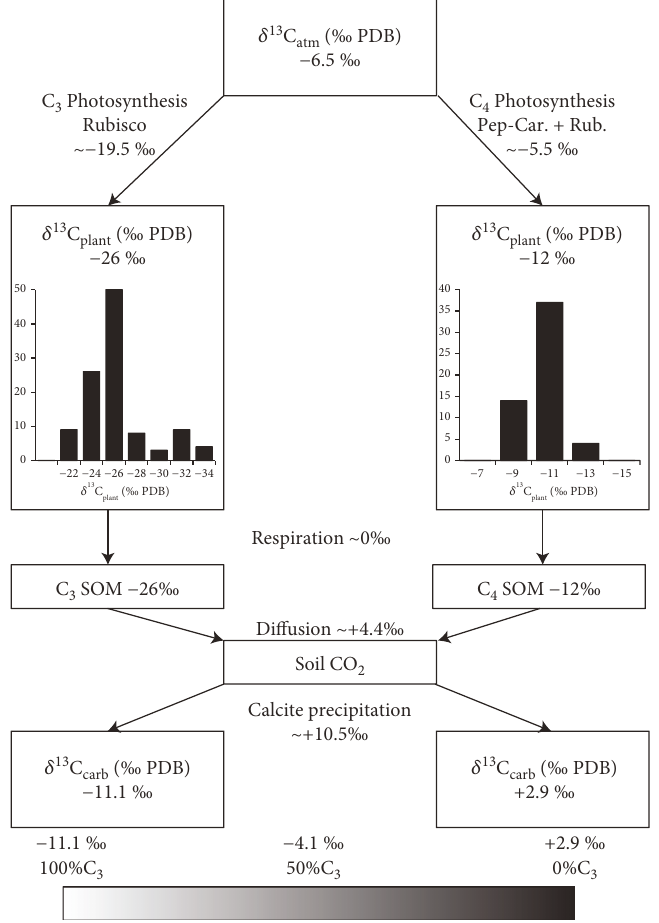
Figure 3: Carbon isotope interpretation framework. This fi gure (design modi fi ed from Koch (1998)) shows the hypothetical C isotopic and C photosynthetic pathways in a preindustrial world. The burning of fossil fuels fractionation pathways for plants using both the C 3 4 has shifted δ 13 C by > − 1.5 ‰ since 1850. Distributions of typical modern C ( n = 109 ) and C ( n = 55 ) δ 13 C values are from Cerling atm 3 4 plant and Harris [48] and have been modi fi ed from the publication by +1.5 ‰ to re fl ect a preindustrial δ 13 C value of − 6.5 ‰ . While there is atm some minor temperature dependence in the C isotope fraction factor between CO and calcite [41], based upon the prevailing theoretical 2 groundwork, δ 13 C values should be ~ +14.9 ‰ relative to their coexisting soil organic matter (SOM). This relationship is empirically carb veri fi ed in Figure